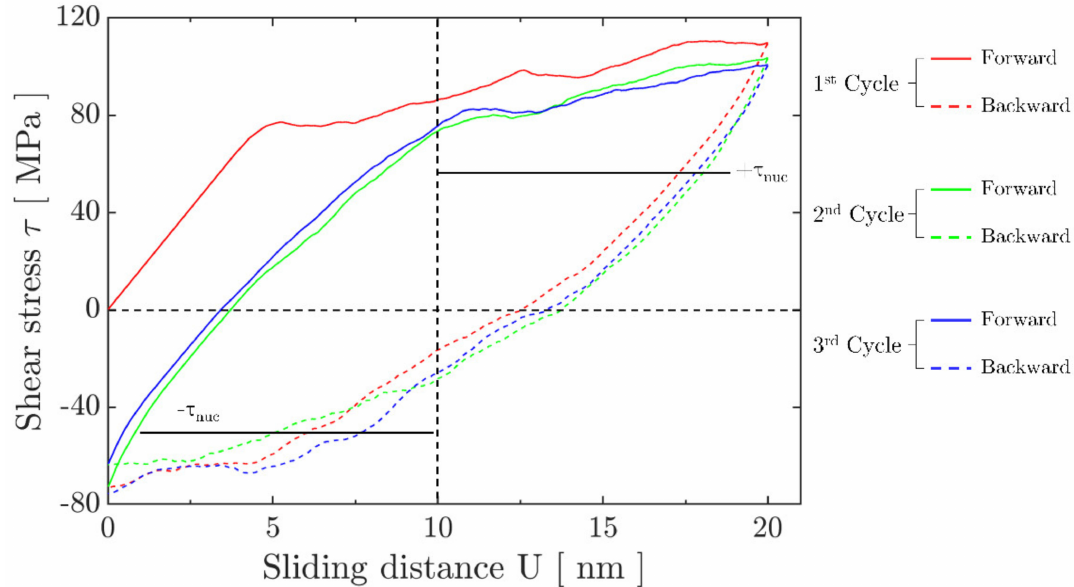
Figure 2. Average shear stress τ evolution during early cycles of a fretting process. Results were obtained by cyclic sliding for a h = 10 µ m film with a stress- and dislocation-free status initially. The contact length is set as A = 2.0 µ